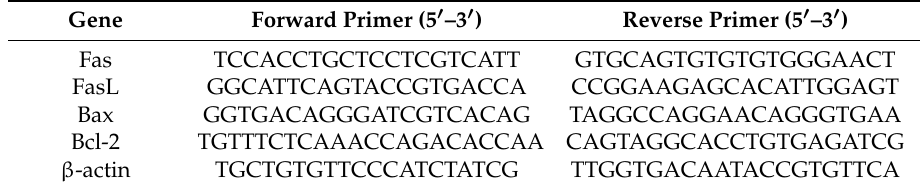
Table 1. Sequences of chicken primer pairs used for quantitative real-time polymerase chain reaction